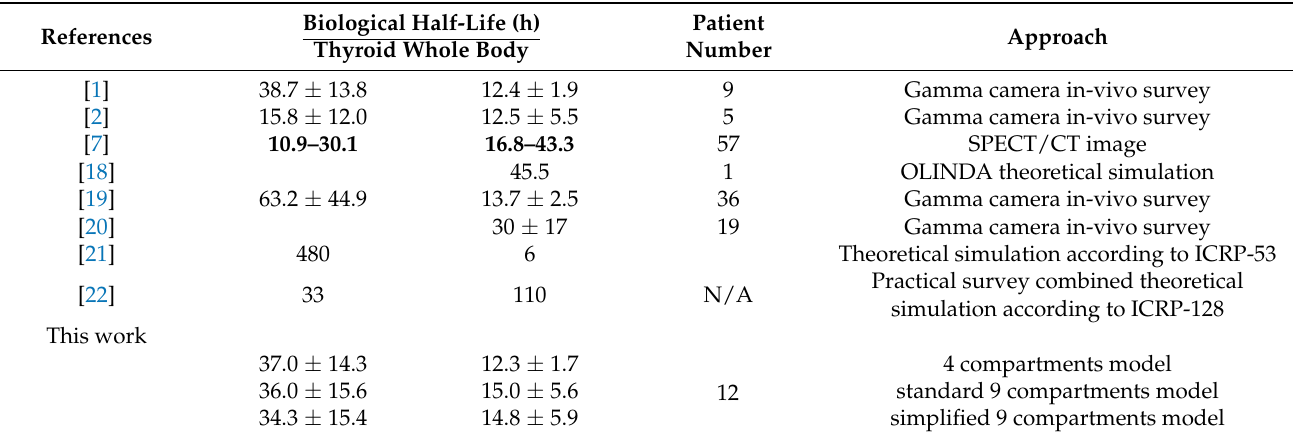
Table 5. The biological half-lives in the major compartments, whole body (BF + WB), and thyroid calculated in this and other studies. The calculations via different practical methods and simulations are quite controversial.